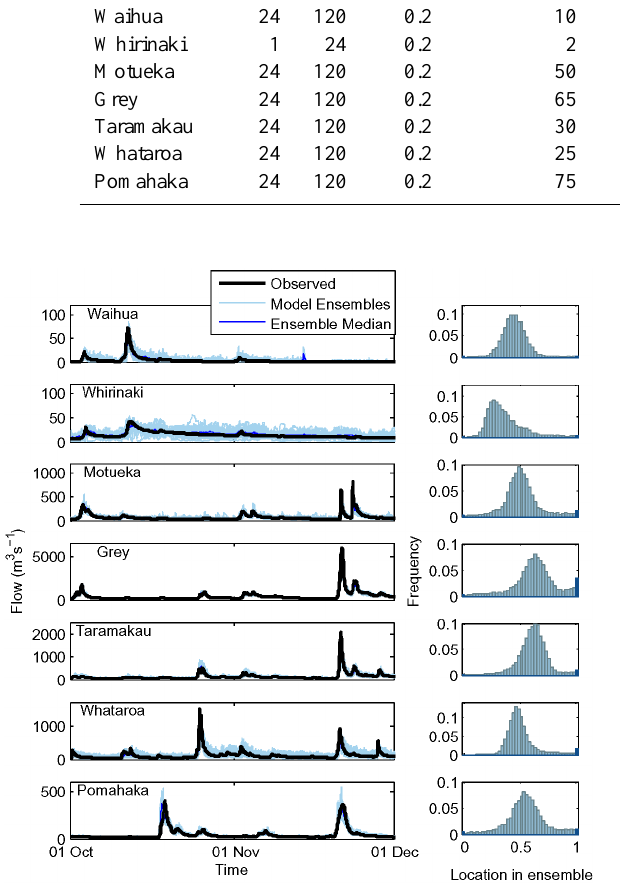
Fig. 6. REnKF simulations for all catchments, showing (left pan- els) ensemble simulations for a 2 month period 1 October 2011– 1 December 2011 (right panels) rank histograms of location of measured flow within the model ensemble, calculated for the year 1 April 2011–31 March 2012. Dark bars at locations 0/1 show ob- servations outside the model ensemble.